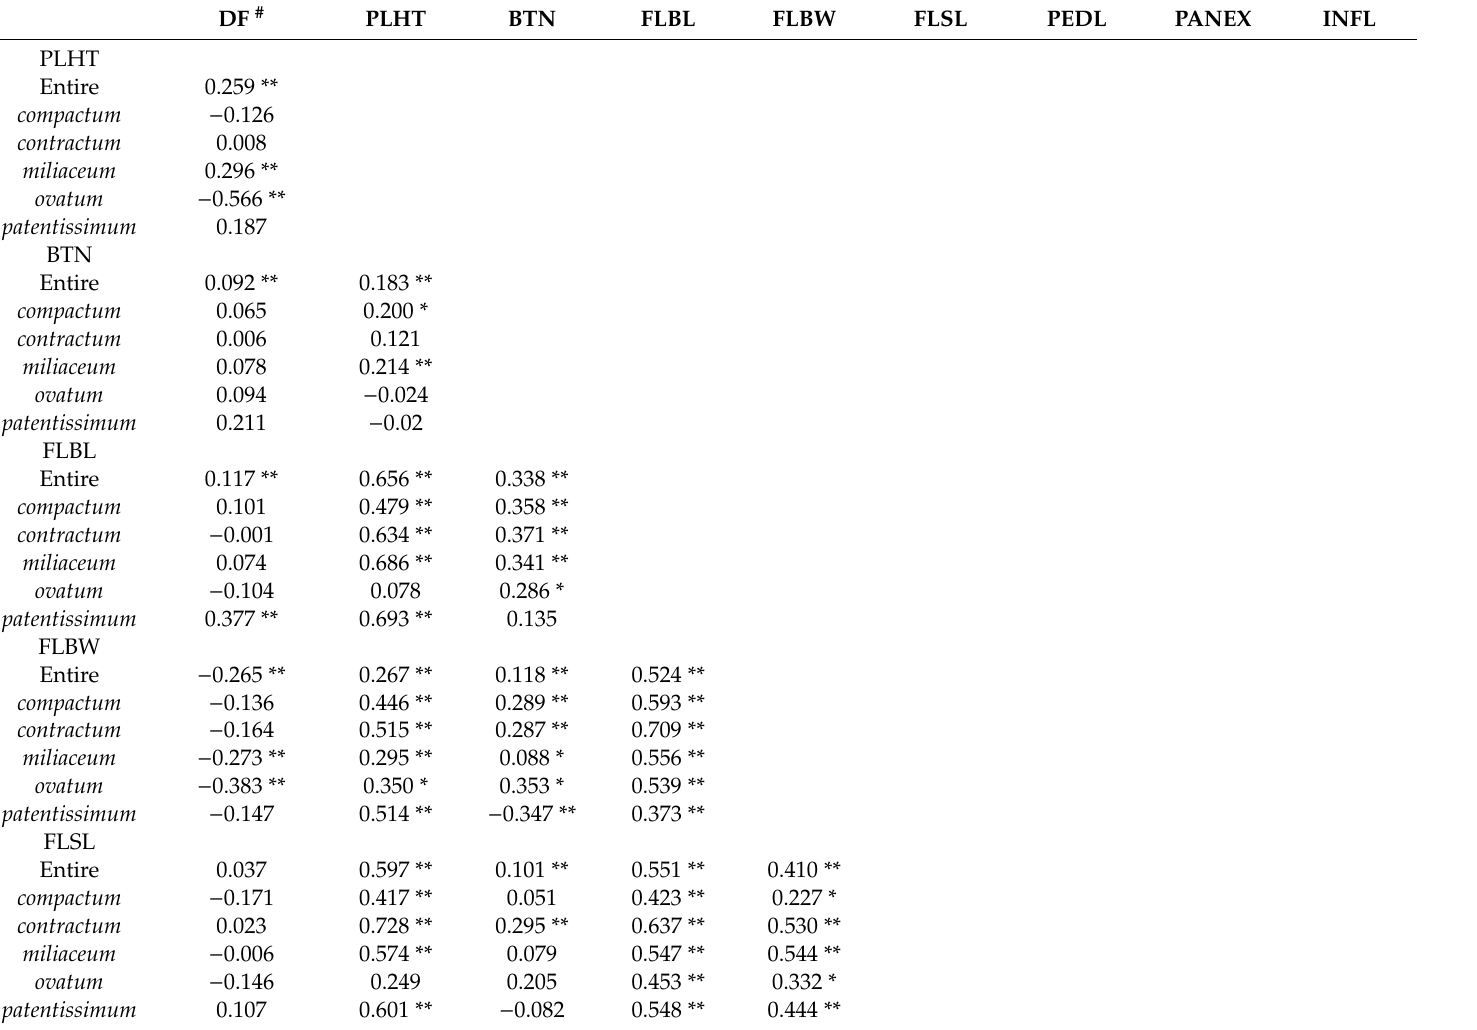
Table 8. Correlation coe ffi cient among quantitative traits of the entire set and each race of proso millet germplasm conserved at the ICRISAT genebank, Patancheru,